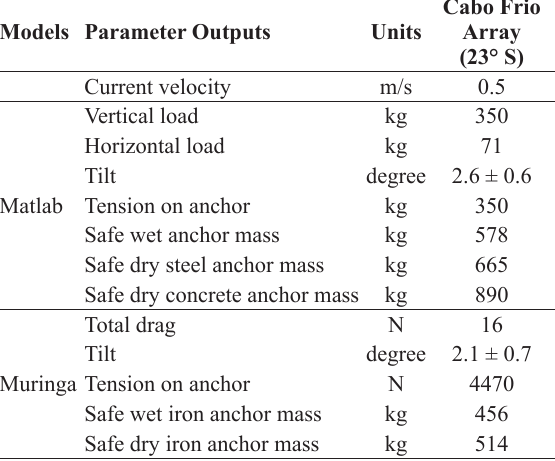
Parameter outputs of the Matlab and Muringa modeling considering a maximum velocity of 0.5